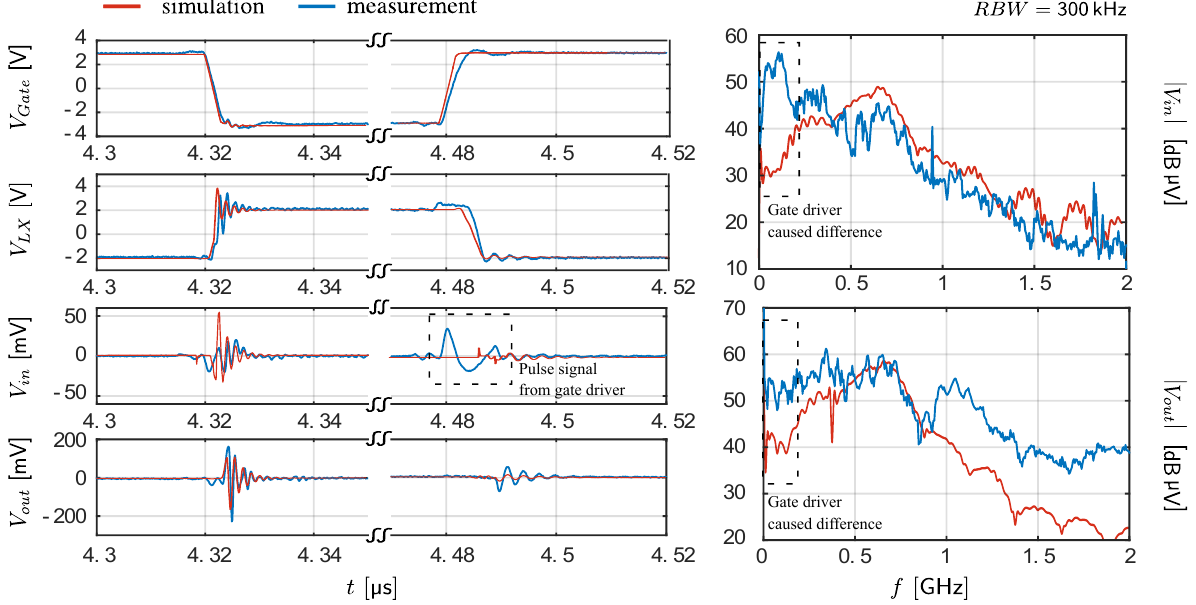
Figure 12. Comparison between measurement (blue) and simulation (red). The gate driver causes spectral content and generates differences in simulation and measurement results at a low